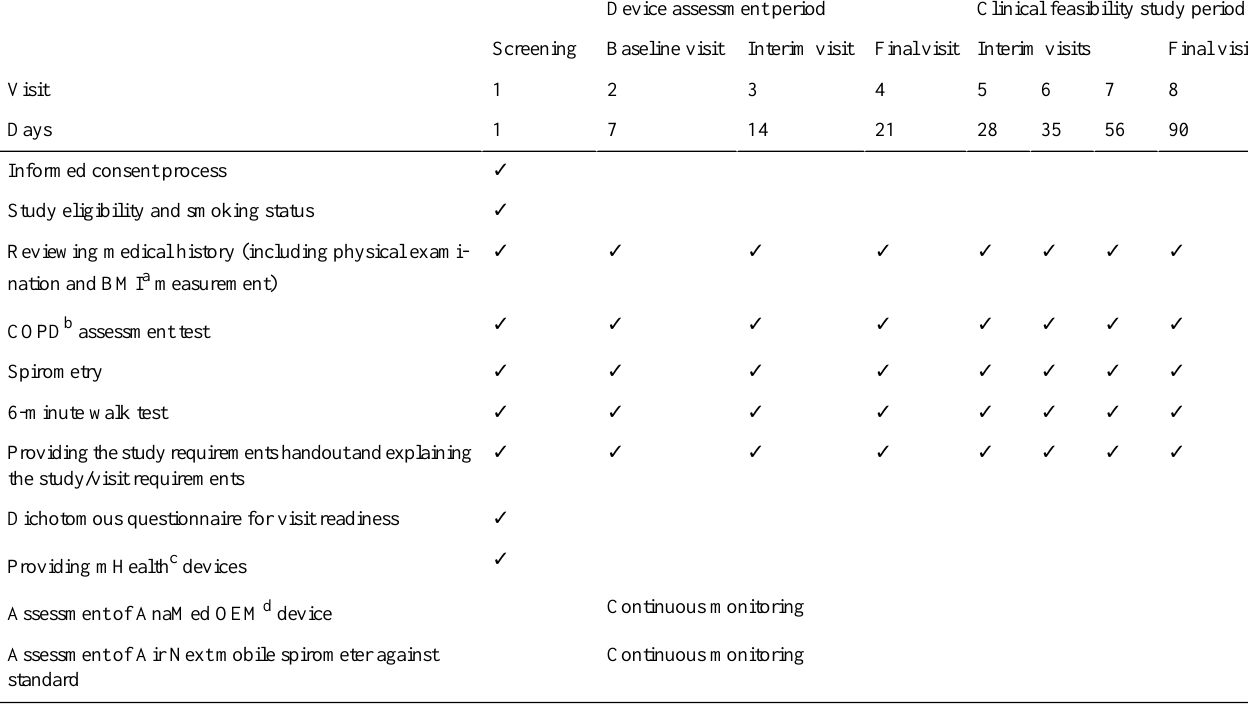
Table 1. Schedule of study